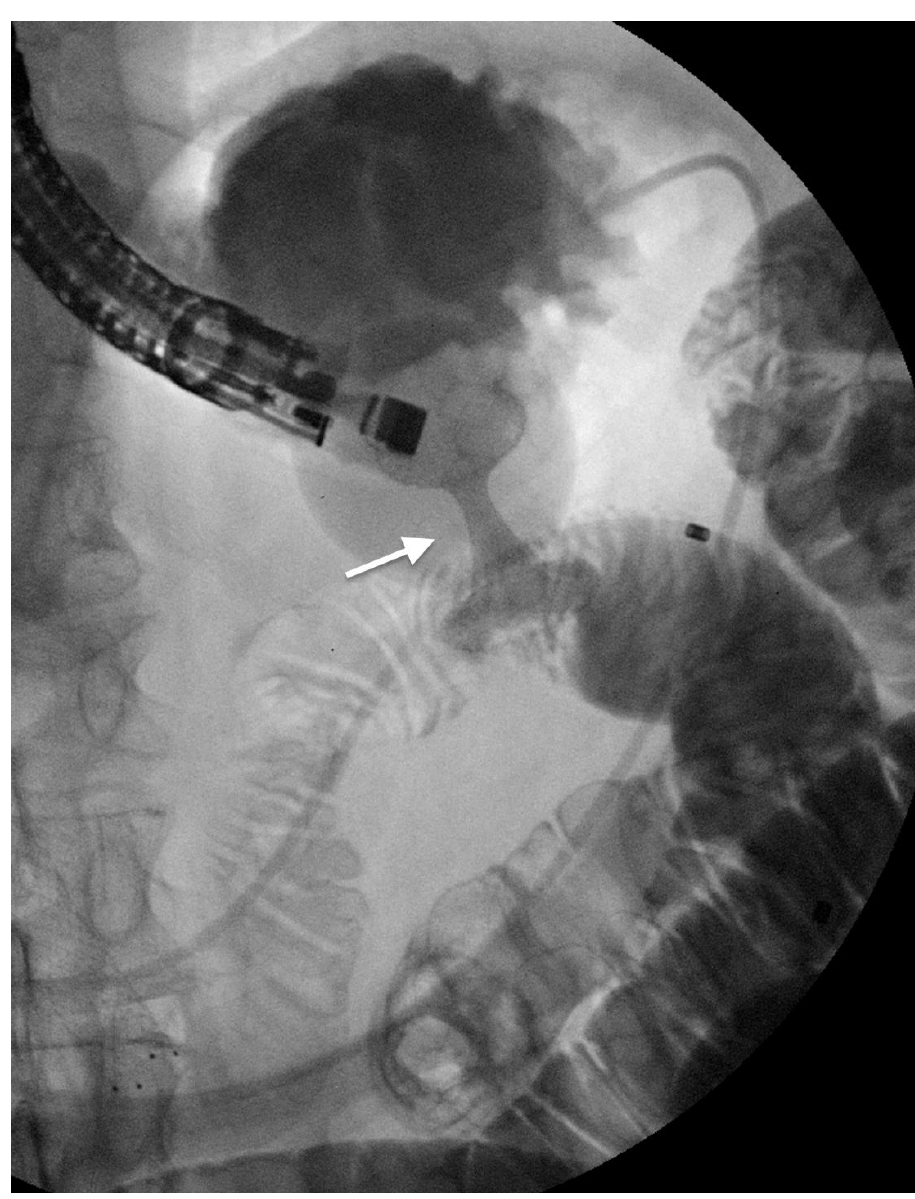
Figure 5. EUS-guided gastro-jejunostomy by lumen-apposing metal stent (arrow). The reported technical and clinical success rates of EUS-GJ were, respectively, 92% and 90%; however, the procedure is burdened by the risk of complications such as stent dislodgement, peritonitis, bleeding, pneumoperitoneum, hemoperitoneum, abdominal pain, and leakage [62]. Similar results were reported by McCarty et al. in a metanalysis of 5 studies, including 199 patients treated with EUS-GJ [63]. They reported a technical success rate of 92.90%, a clinical success rate of 90.11%, an AEs occurrence rate of 5.61%, and a reintervention rate of 11.43%. Boghossian et al. performed a metanalysis in order to compare the clinical outcomes of EUS-GJ, endoscopic stents (ES), and surgical gastrojejunostomy (SGJ) [64]. Comparing EUS-GJ and ES, the technical success rate was 93% and 98%, respectively; the clinical success rate was 88% and 78%, respectively; the AEs rate was 11% and 31%, respectively; and the occurrence of stent occlusion was 3% and 24%, respectively. Moreover, comparing EUS-GJ and SGJ, the technical success rate was 91% and 100%, respectively; the clinical success rate was 86% and 90%, respectively; the AEs rate was 11% and 10%, respectively; and the length of hospital stay was longer in